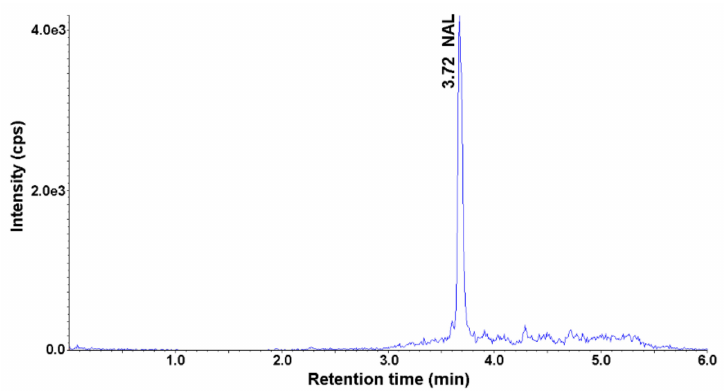
Figure 4. Representative MRM chromatogram of the parsley root sample obtained after application of SLE-SPE-HPLC-UV-MS/MS